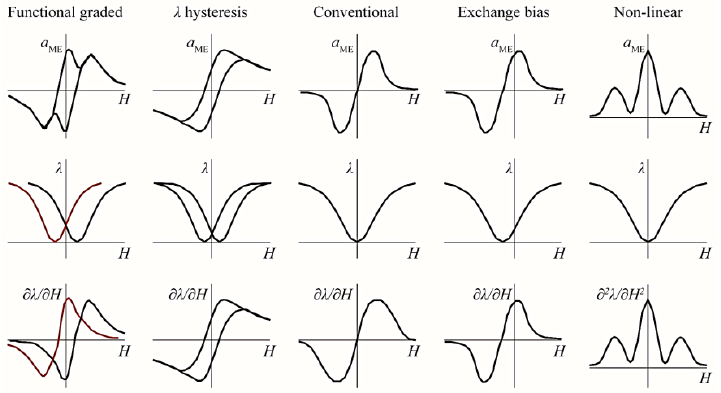
Figure 5. Schematic representation of different types of self-biased ME composites with different α ME -H (top row), λ-H (middle row), and q-H curves (bottom row) [51].